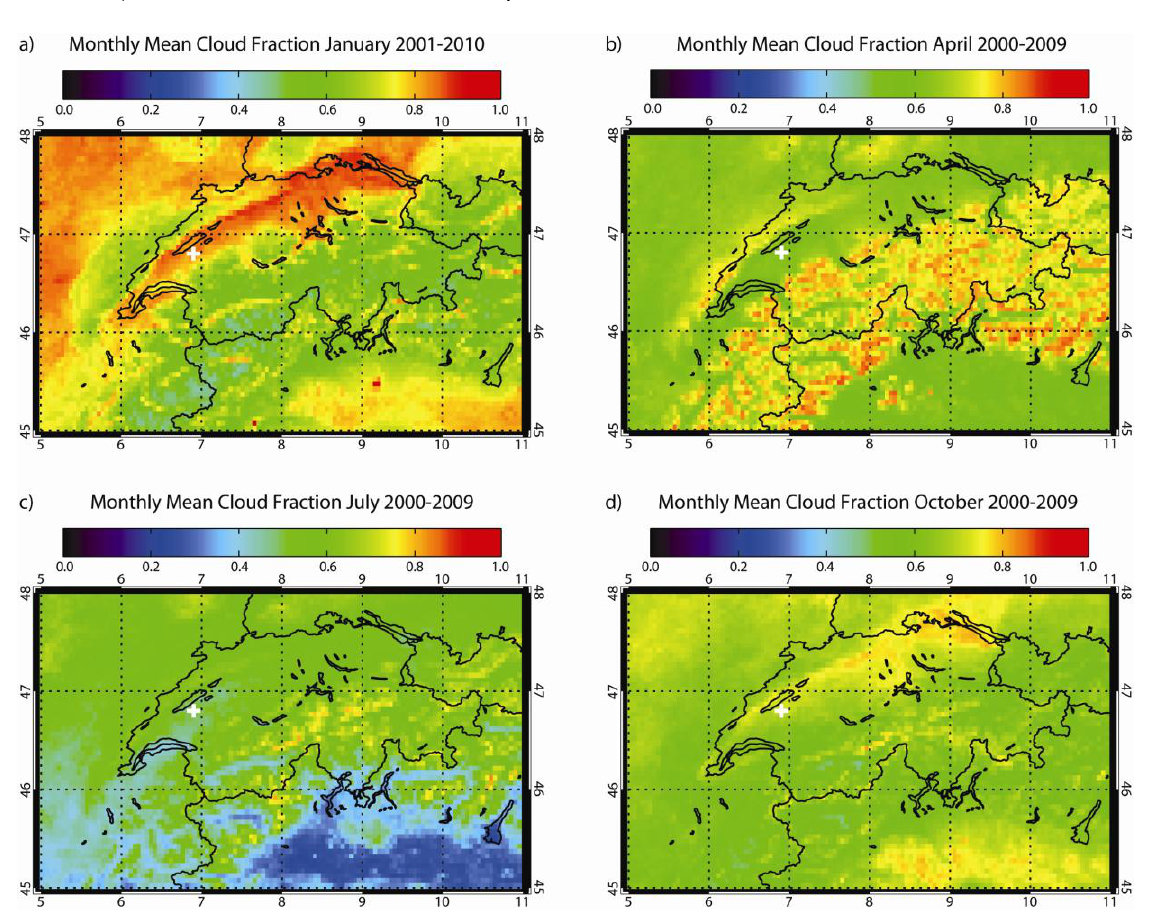
Figure 2. 10-year monthly mean cloud fraction from MODIS (Terra), at 0.05°